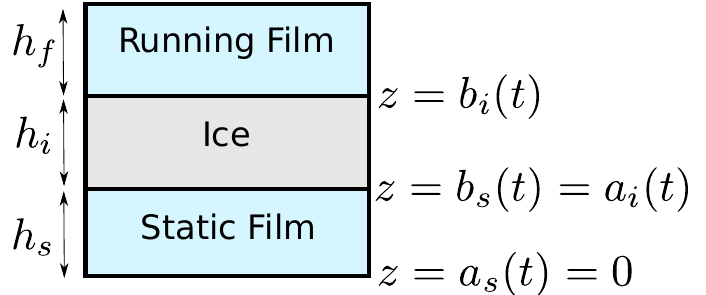
Figure 6. Illustration of the three layers: h f , h i , and h s are the heights of the running film, ice, and static (melted) film. The a k ’s and b k ’s represent the positions of the boundaries between each layer in the z direction (normal to the surface). Reprinted from [22],